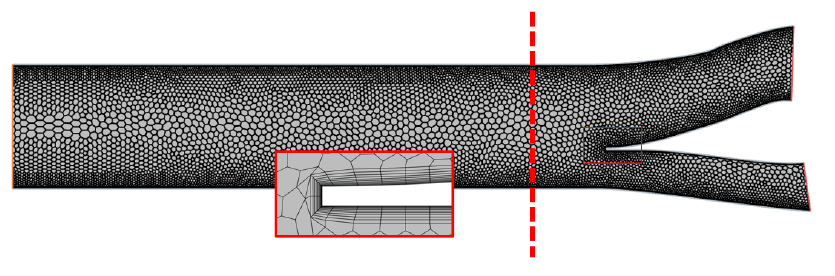
Figure 6. 2D mesh. The dashed red line marks the end of the axisymmetric body in the original